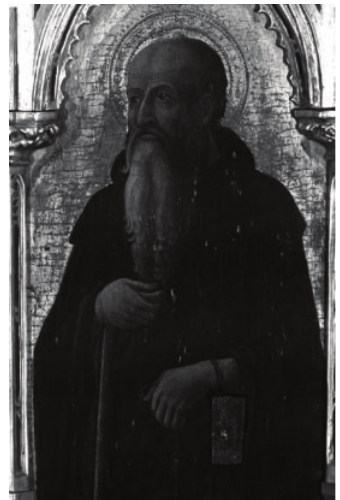
Figure 1: St. Antonio Abbot attributed to Bartolomeo Vivarini, section of a polyptych dating back to the 15th century, Lecce, Museum “Sigismondo Castromediano”: image acquired in the visible spectrum